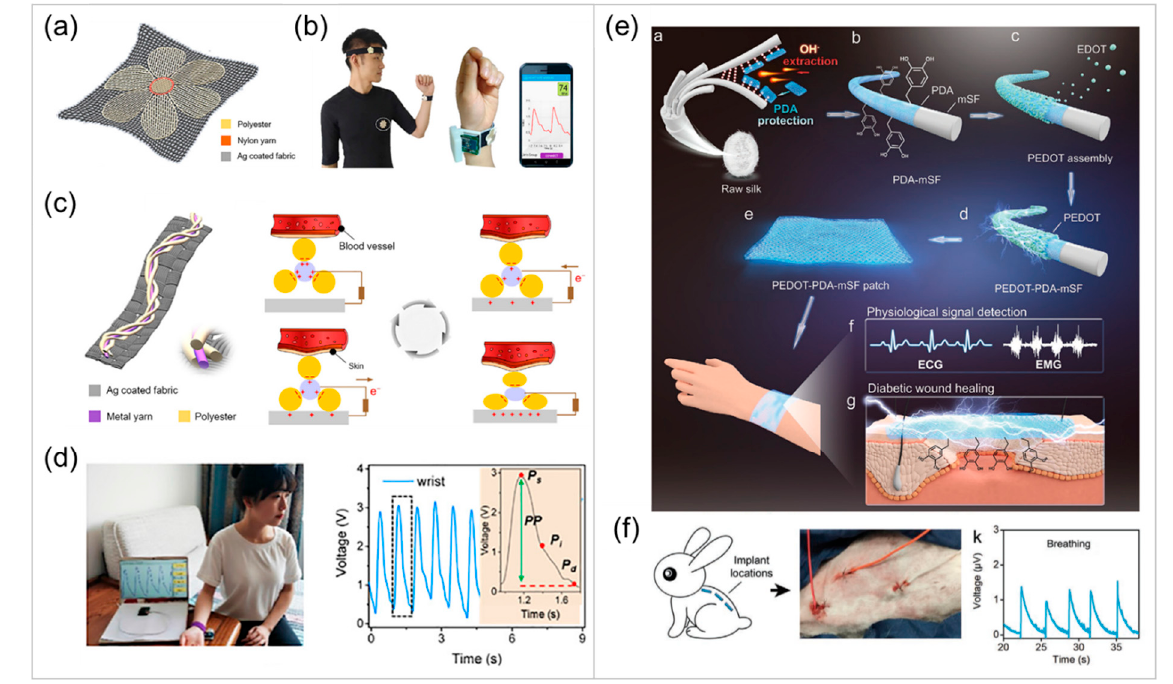
Figure 5. ( a ) Schematic illustration of the as-fabricated textile-based sensor. ( b ) Photographs of a wireless biomonitoring system based on a wearable textile sensor. ( c ) Schematic illustration of a 3D honeycomb-structured triboelectric nanogenerating fiber and working mechanism. ( d ) The textile-based wireless biomonitoring system and the acquired pulse wave signals when worn by a woman. ( a – d ) Reproduced with permission Ref. [47]. Copyright 2020, Elsevier. ( e ) Schematics of the fabrication process and a silk-based patch for diabetic wound healing. ( f ) A photograph of patches implanted as electrodes in a rabbit’s back (left image) and signals detected after breathing. ( e , f ) Reproduced with permission Ref. [61]. Copyright 2021, Wiley-VCH.